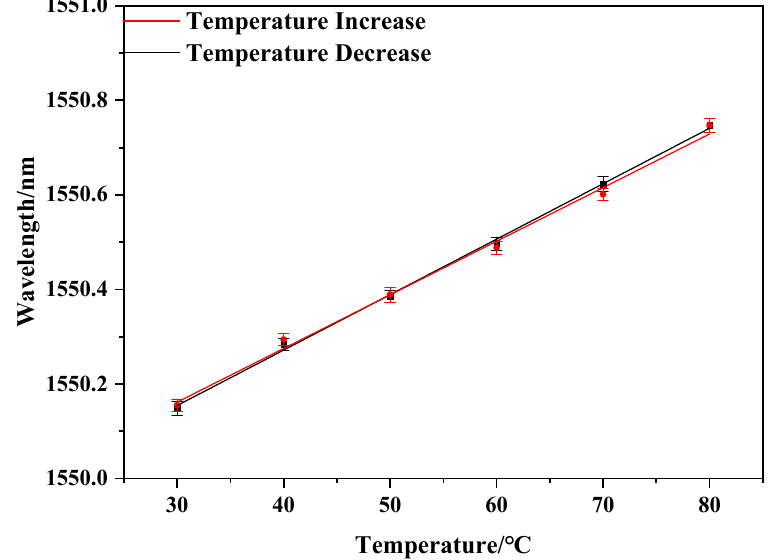
Figure 13. Temperature response fitting curve.